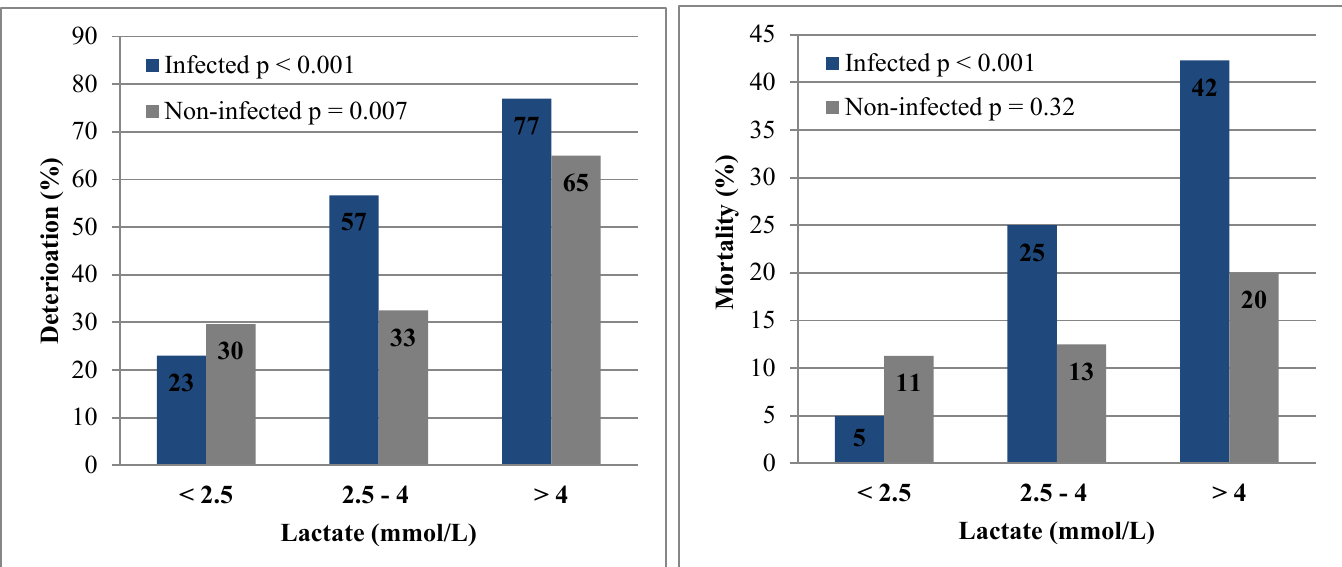
Figure 1. Incidence of deterioration and death in patients with and without infection stratified by lactate concentration; P-values by chi-square test for trend for positive association across stratified lactate levels.